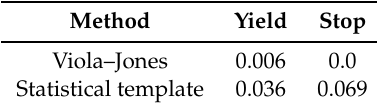
Table 2. False alarm rate per frame.